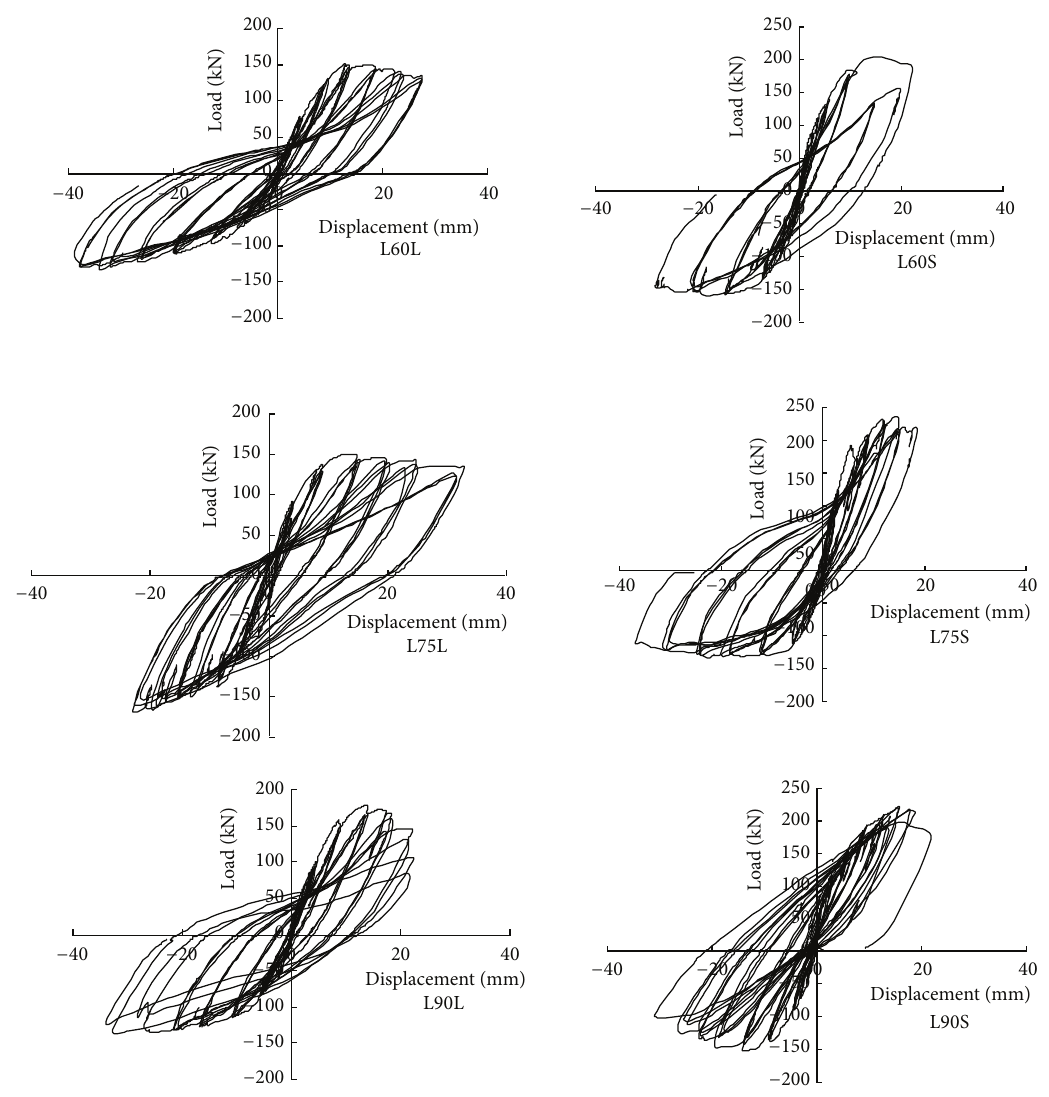
Figure 5: Load-deflection behaviors of L-shaped columns.